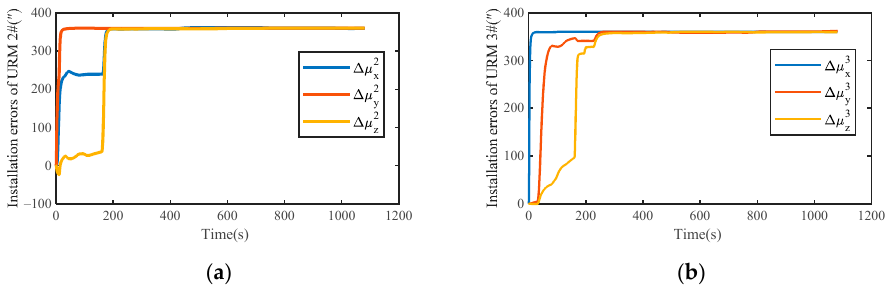
Figure 7. ( a ) Simulation results of installation errors for URM 2#; ( b ) simulation results of installation errors for URM 3#.